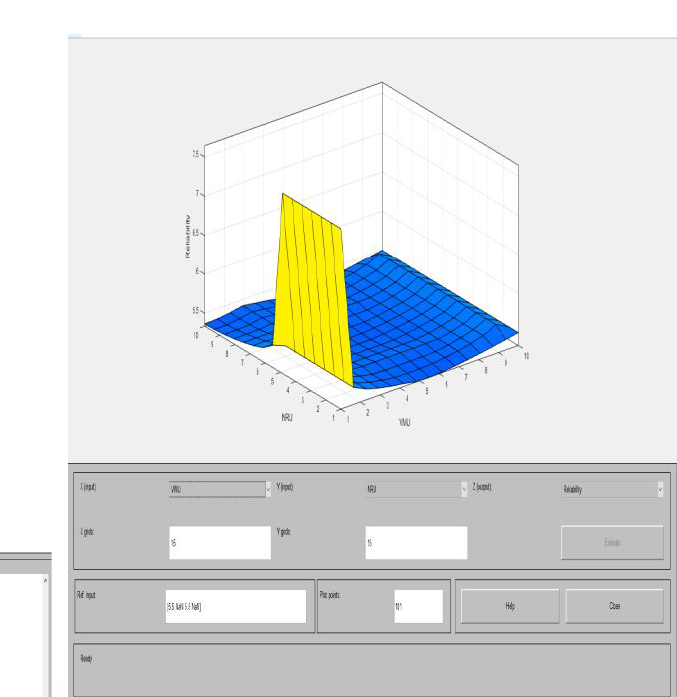
Figure 7. Rule surface for Reliability